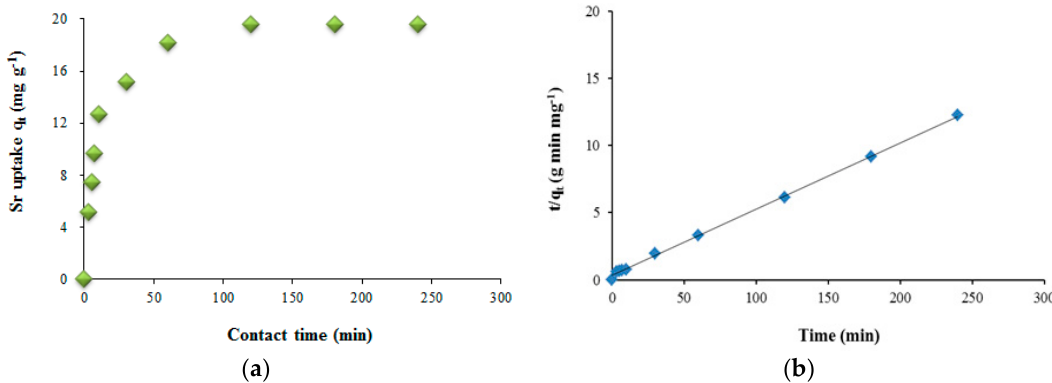
Figure 4. ( a ) Effect of the contact time on Sr adsorption; and ( b ) pseudo ‐ second ‐ order plot. Conditions: Adsorbent dose 5 g ∙ L − 1 , pH 10.25, T 298 K, ionic strength 0.5 mol ∙ L − 1 .